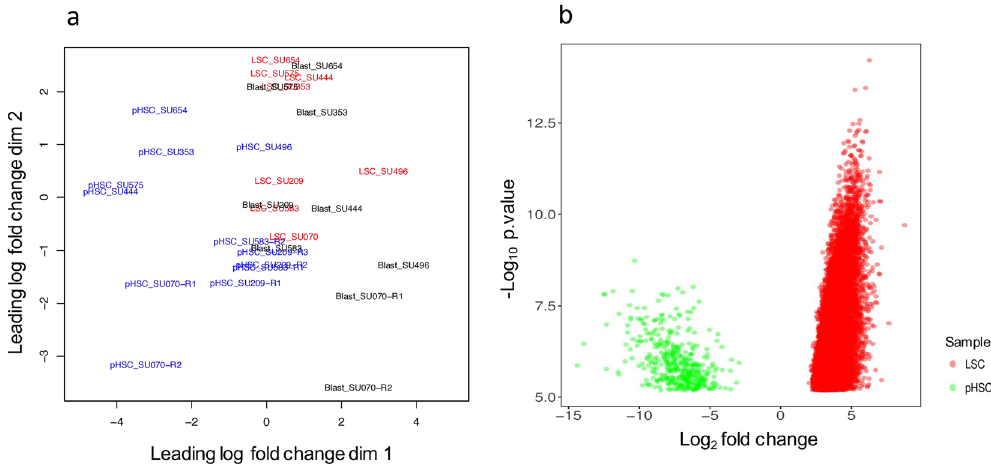
Figure 6. Chromatin accessibility in pHSCs, LSCs, and Blasts ( a ) Multi-dimensional scaling plot with two dimensions showing similarity between different ATACseq samples: pHSC (blue), LSC (red), and Blast (black). ( b ) Depicts the differential accessibility using ATACseq sampling data comparing LSCs to pHSC. X-axis is log 2 fold change of differentially accessible regions (Supplement table 4); Y-axis is –log 10 of the p.values reported from comparison. The minimum p.value considered was